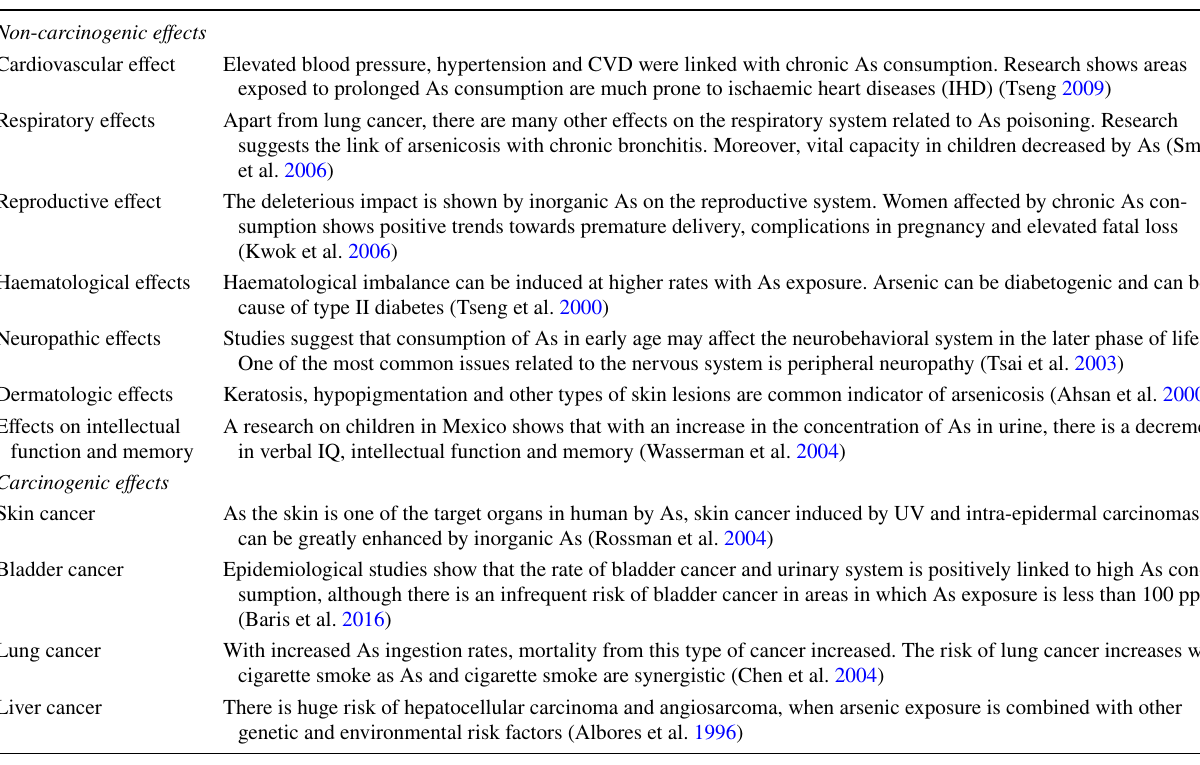
Table 1 Ways in which As effects human